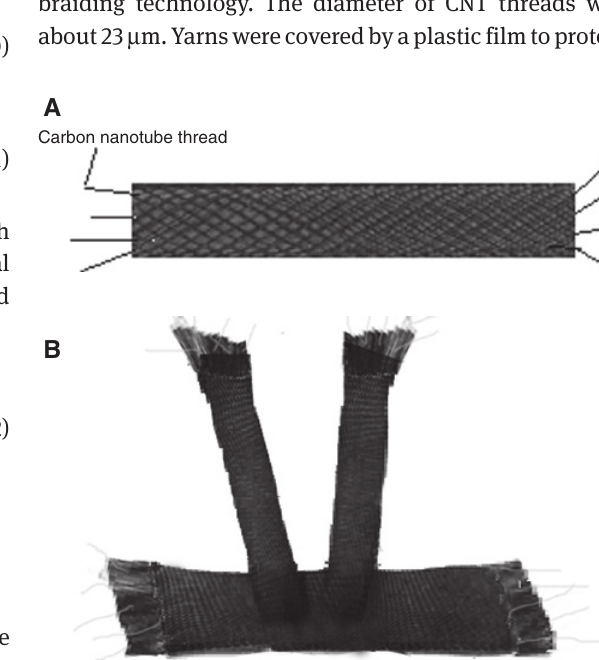
Figure 6: The image of 3D braided composite